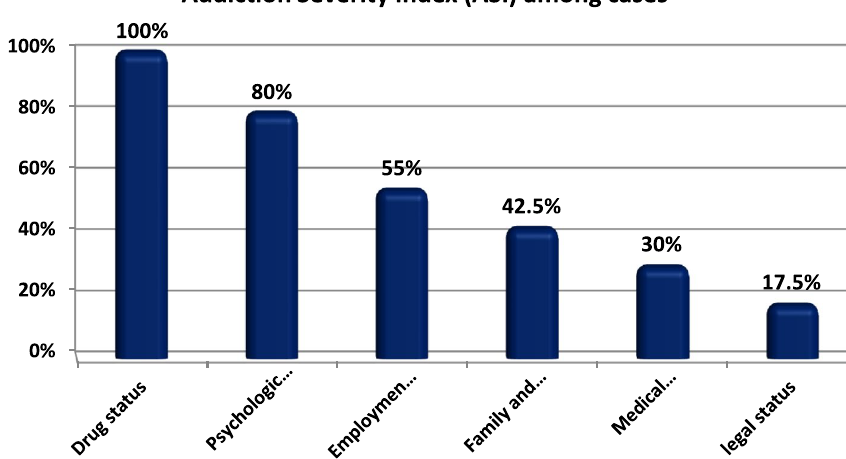
Fig. 1 Severity of addiction according to Addiction Severity Index scale among